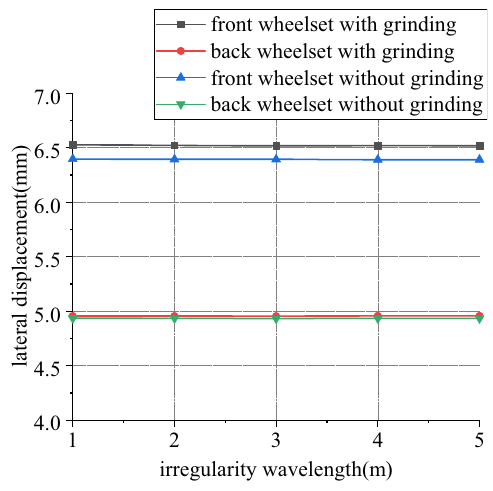
Figure 23. Wavelength and lateral displacement (case 2).